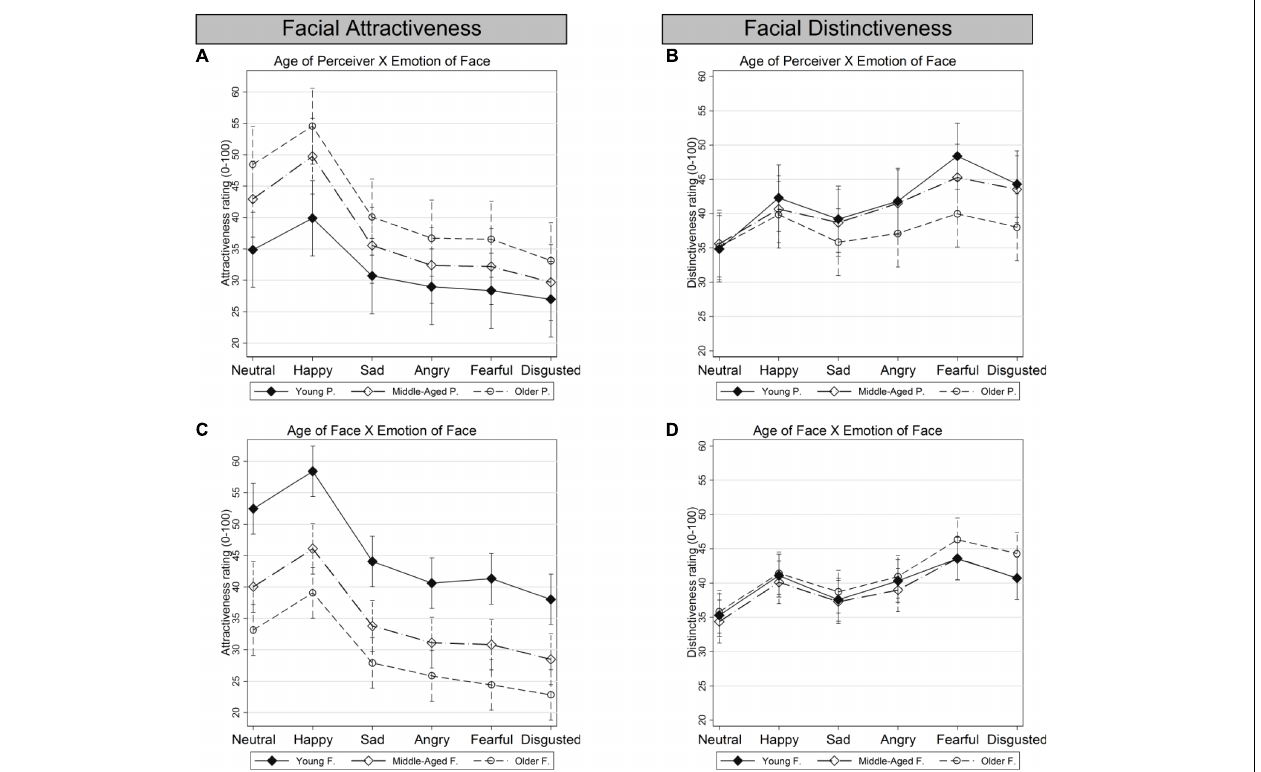
FIGURE 3 | Predicted marginal means for attractiveness and distinctiveness for specified two-way interactions pertaining to age, gender, and emotion of face: (A) Age of Perceiver × Emotion of Face, for attractiveness. (B) Age of Perceiver × Emotion of Face, for distinctiveness. (C) Age of Face × Emotion of Face, for attractiveness. (D) Age of Face × Emotion of Face, for distinctiveness. Error bars indicate 95% confidence intervals for the point predictions, corrected for multiple comparisons (Bonferroni). P = Perceiver; F =